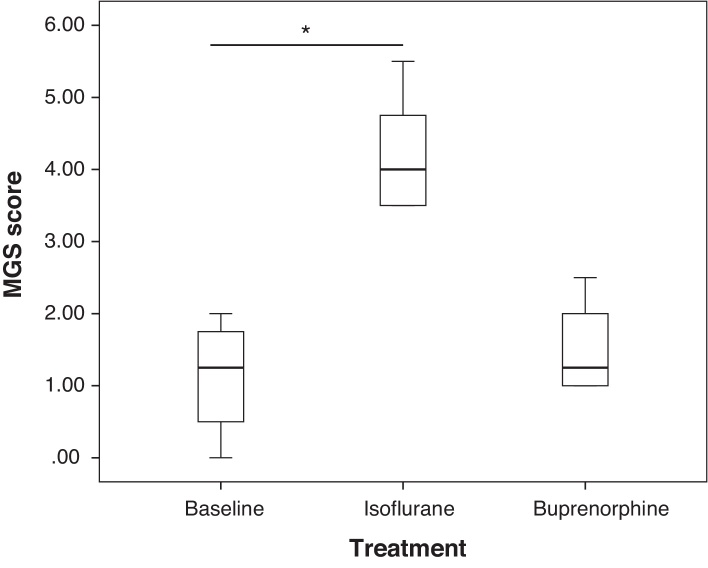
Box plot of MGS scores in DBA/2 mice at baseline and following either isoflurane anaesthesia or 0.05 mg/kg buprenorphine alone. The whisker FAU was excluded from the analysis (maximum obtainable score was 8).